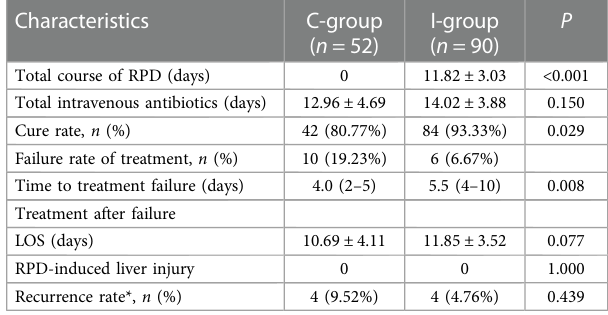
TABLE 2 Outcomes of conservative treatment for the control group and intervention group after treatment. Characteristics